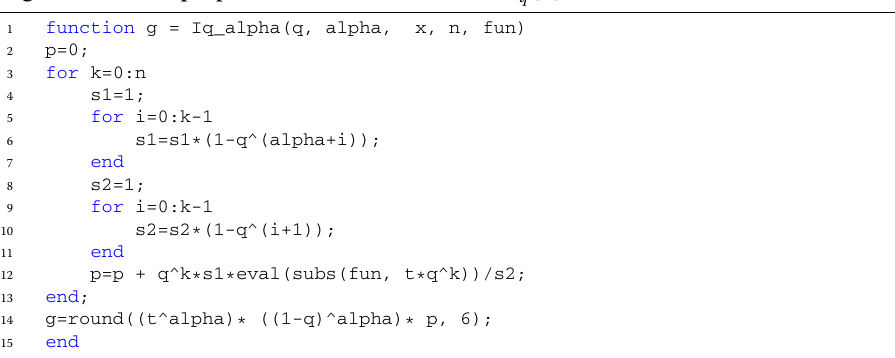
Algorithm 4 The proposed method for calculated I α